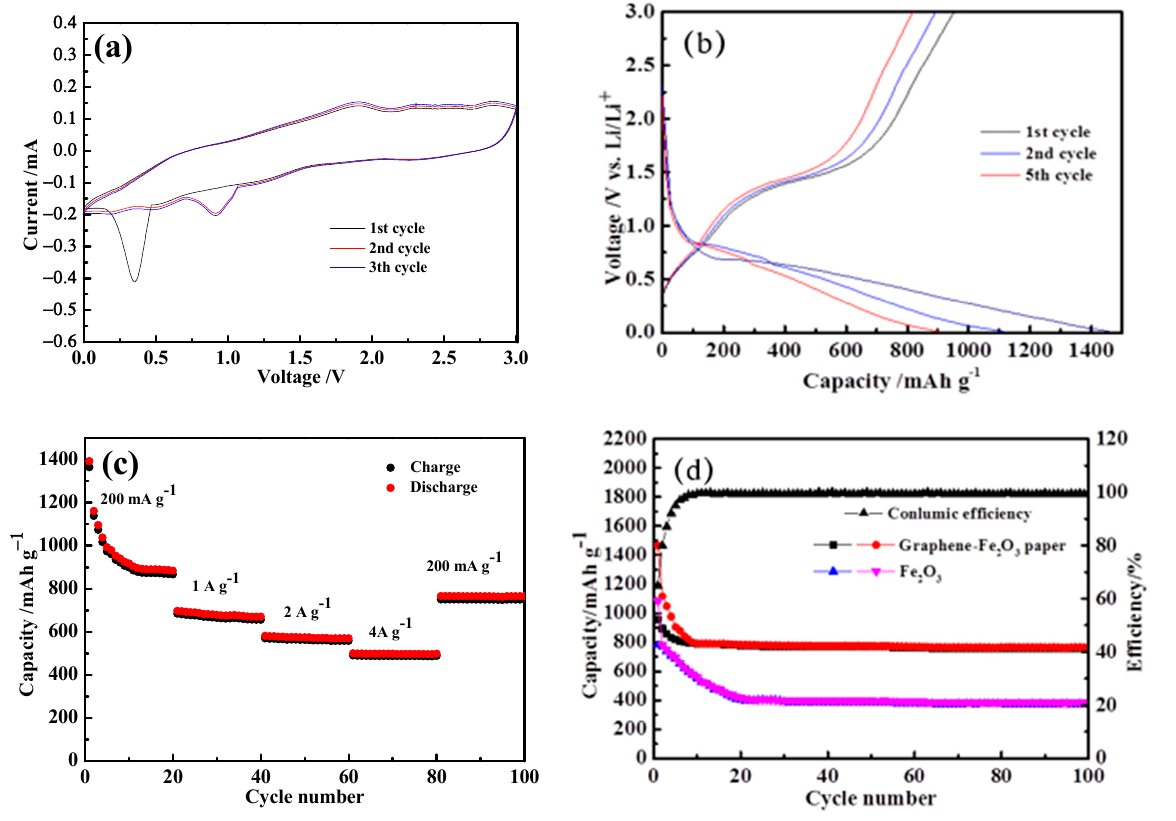
Figure 7. The electrochemical property of the obtained samples as the anode for LIBs; ( a ) CV curves of the graphene-Fe 2 O 3 sheet electrode at a scan rate of 0.5 mV · s − 1 ; ( b ) the charge-discharge voltage curves of the graphene-Fe 2 O 3 sheet electrode at the current density of 200 mA · g − 1 for the cycle of 1st, 2nd, and 5th; ( c ) the rate capabilities of the graphene-Fe 2 O 3 sheet anodes at the current densities ranging from 0.2 to 4.0 A · g − 1 ; ( d ) the cycle performance and Coulombic efficiency of the graphene-Fe 2 O 3 sheet and pure Fe 2 O 3 anodes at the current density of 200 mA · g − 1 for 100 cycles. Table 1. Anodes for LIBs based on graphene-Fe 2 O 3 materials and their electrochemical perfor- mance.